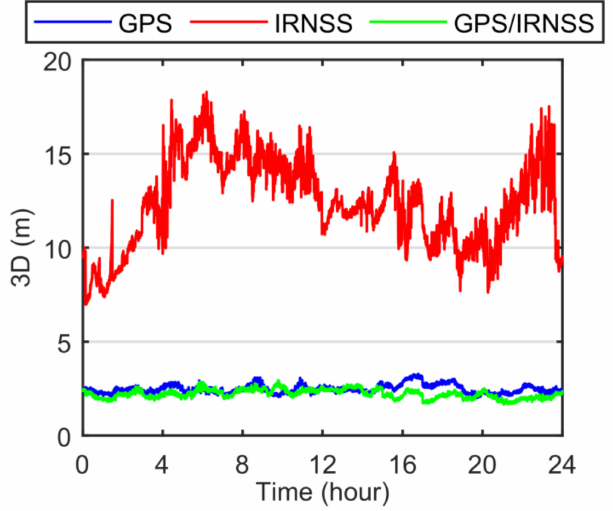
Figure 10. Epoch-wise RMS statistics of positioning errors in the 3D direction for IRNSS-only, GPS- only and GPS/IRNSS SPP based on the datasets collected at 14 MGEX stations on 7–13 July 2019.